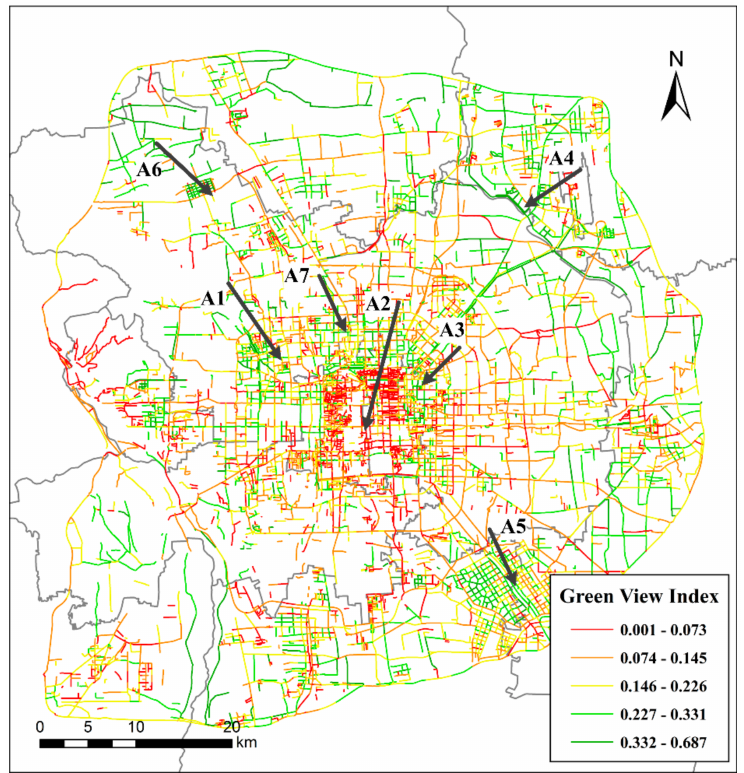
Figure 8. The green view index (GVI) values at street level. The GVI values have been aggregated from site-level GVI values in Figure 7. This map shows the spatial distribution of GVI at street level. Markers A1–A7 were used to identify the concentration areas of very high or low GVI in the study